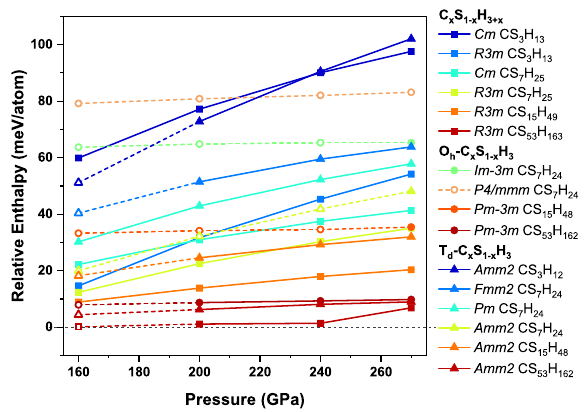
Fig. 4 Δ H as a function of pressure. Formation enthalpies are calculated via the following reaction: C þ x ð H 3 S Þ þ y (cid:2) 3 x CS x H y in meV/atom using the diamond phase of carbon 73 , C 2/ c phase of H 274 and Im 3 m phase of H 3 S 16 as a reference. The open (closed) circles correspond to structures that were found to be dynamically unstable (stable). For a plot of the full enthalpy range see Supplementary Fig. 26.